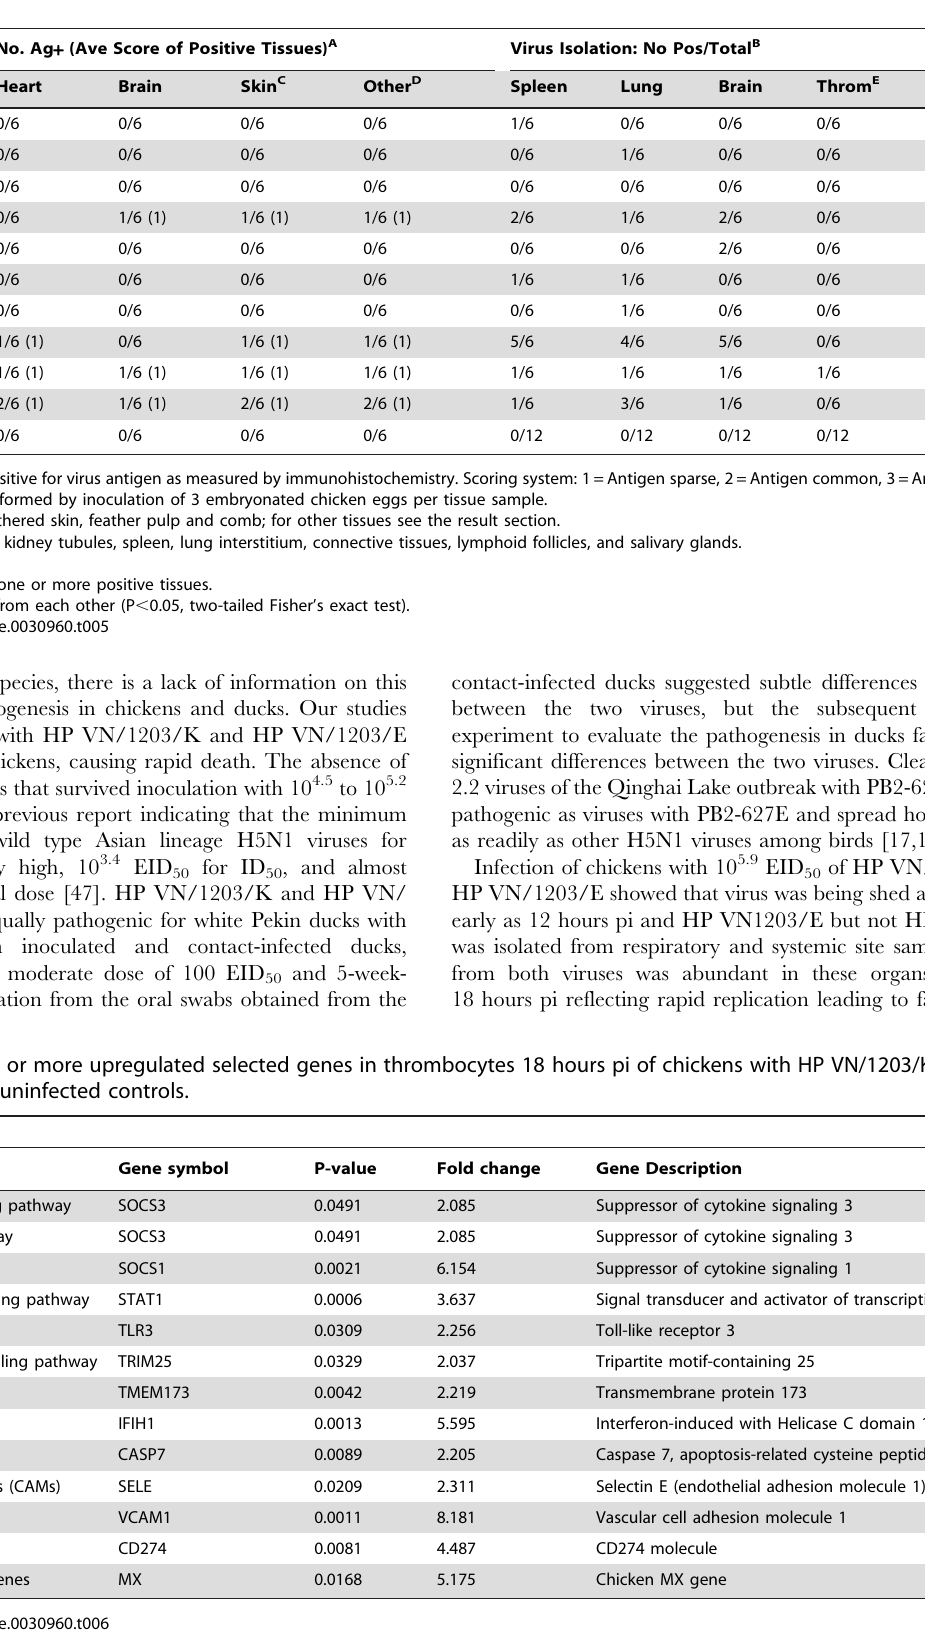
Table 5. Pathogenesis of infection with LP VN/1203/K and LP VN/1203/E in chickens.